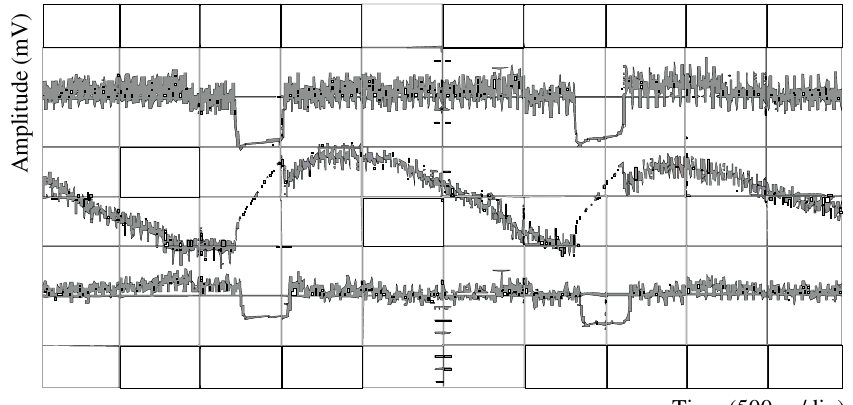
FIG. 1. Measured baseline drift in a PS electrostatic pickup during bunch compression prior to extraction. From top to bottom: (cid:21) ( 300 mV = div ), (cid:24) y ( 20 mV = div ), and (cid:24) x ( 200 mV = div ). The 30 MHz bandwidth of the pickup does not allow discriminating the 4 ns long bunches. The bunch train lasts 1 : 8 (cid:5) s and the gap is 320